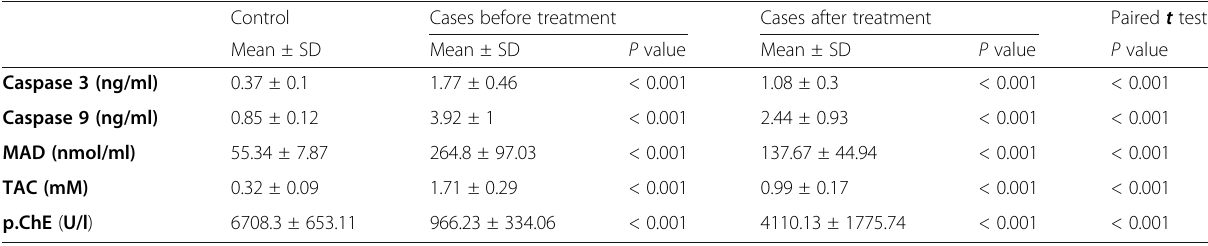
Table 1 Comparison between caspase 3, caspase 9, MAD, and TAC in acute OP poisoning cases before and after treatment (paired t test) and both compared to the control group ( t test)